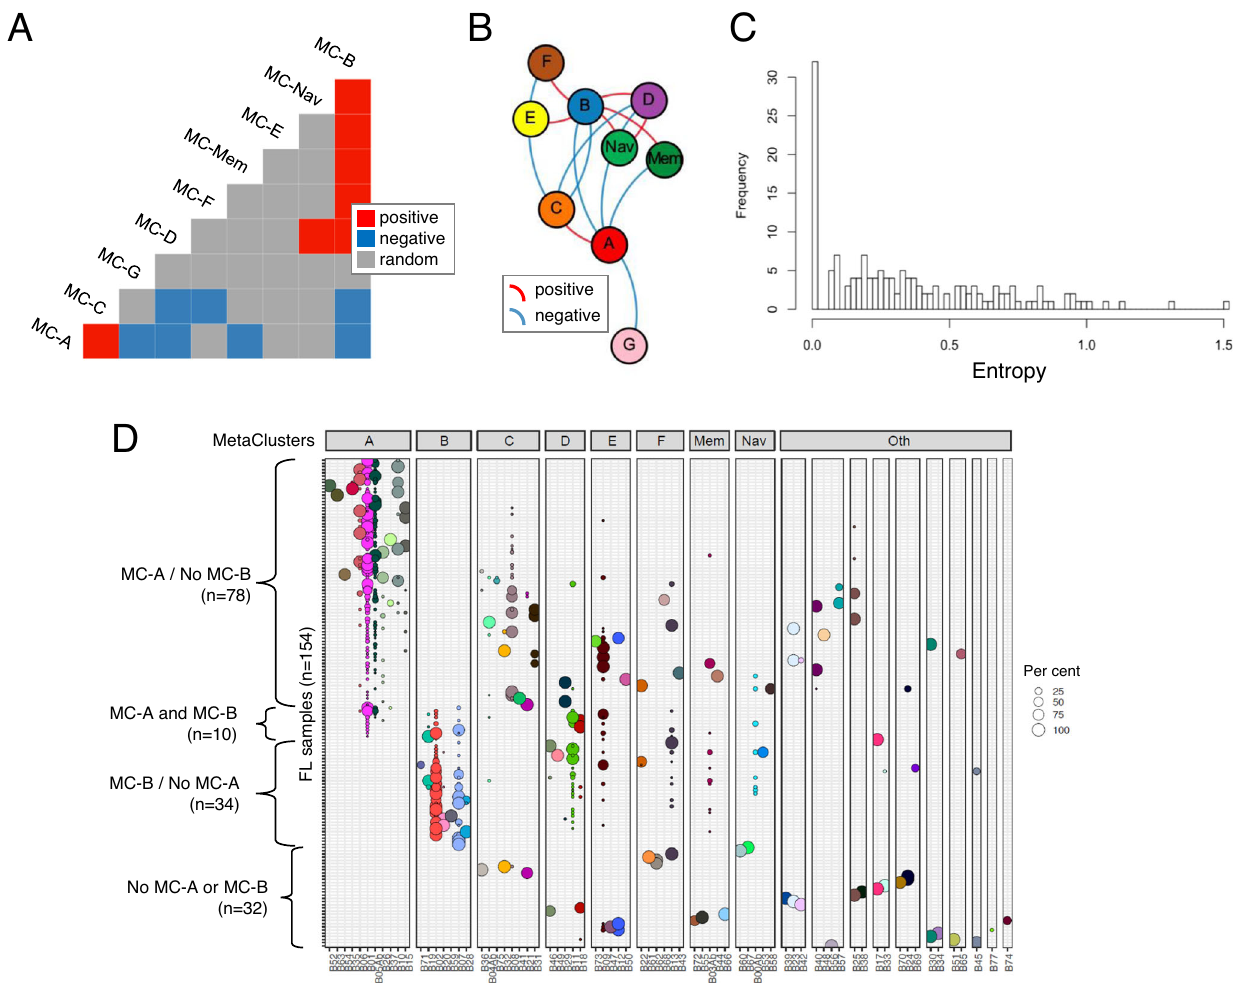
Fig. 3 | B-cell cluster composition analysis reveals recurrent patterns within samples. A , B Co-occurrence analysis for B-cell MC groups. Probabilistic model- basedco-occurrence analysiswasperformedusingmalignantB-cellsonlyfrom154 FL samples without additional adjustment for multiple testing (see Methods sec- tion). A Co-occurrence matrix. Blue and yellow shaded boxes indicate statistically signi fi cant positive and negative co-occurrences, respectively ( p <0.05; probabil- istic model-based co-occurrence test, 2-sided). B Co-occurrence network diagram. Force-directed graphing of co-occurrence associations. Each node represents a B-cell MC group. Edges indicate statistically signi fi cant positive or negative co- occurrenceassociations( p